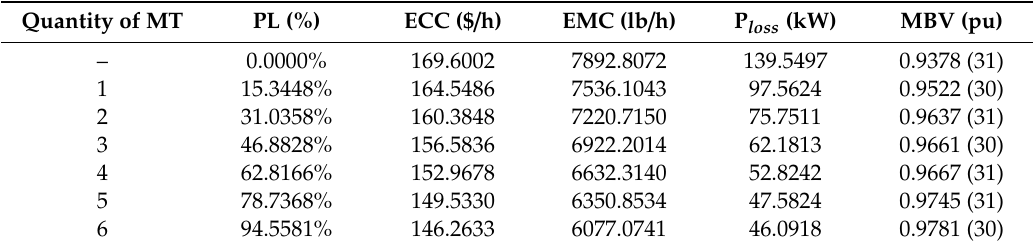
Table 7. Reconfiguration results of the increasing microturbine (MT) deployment.